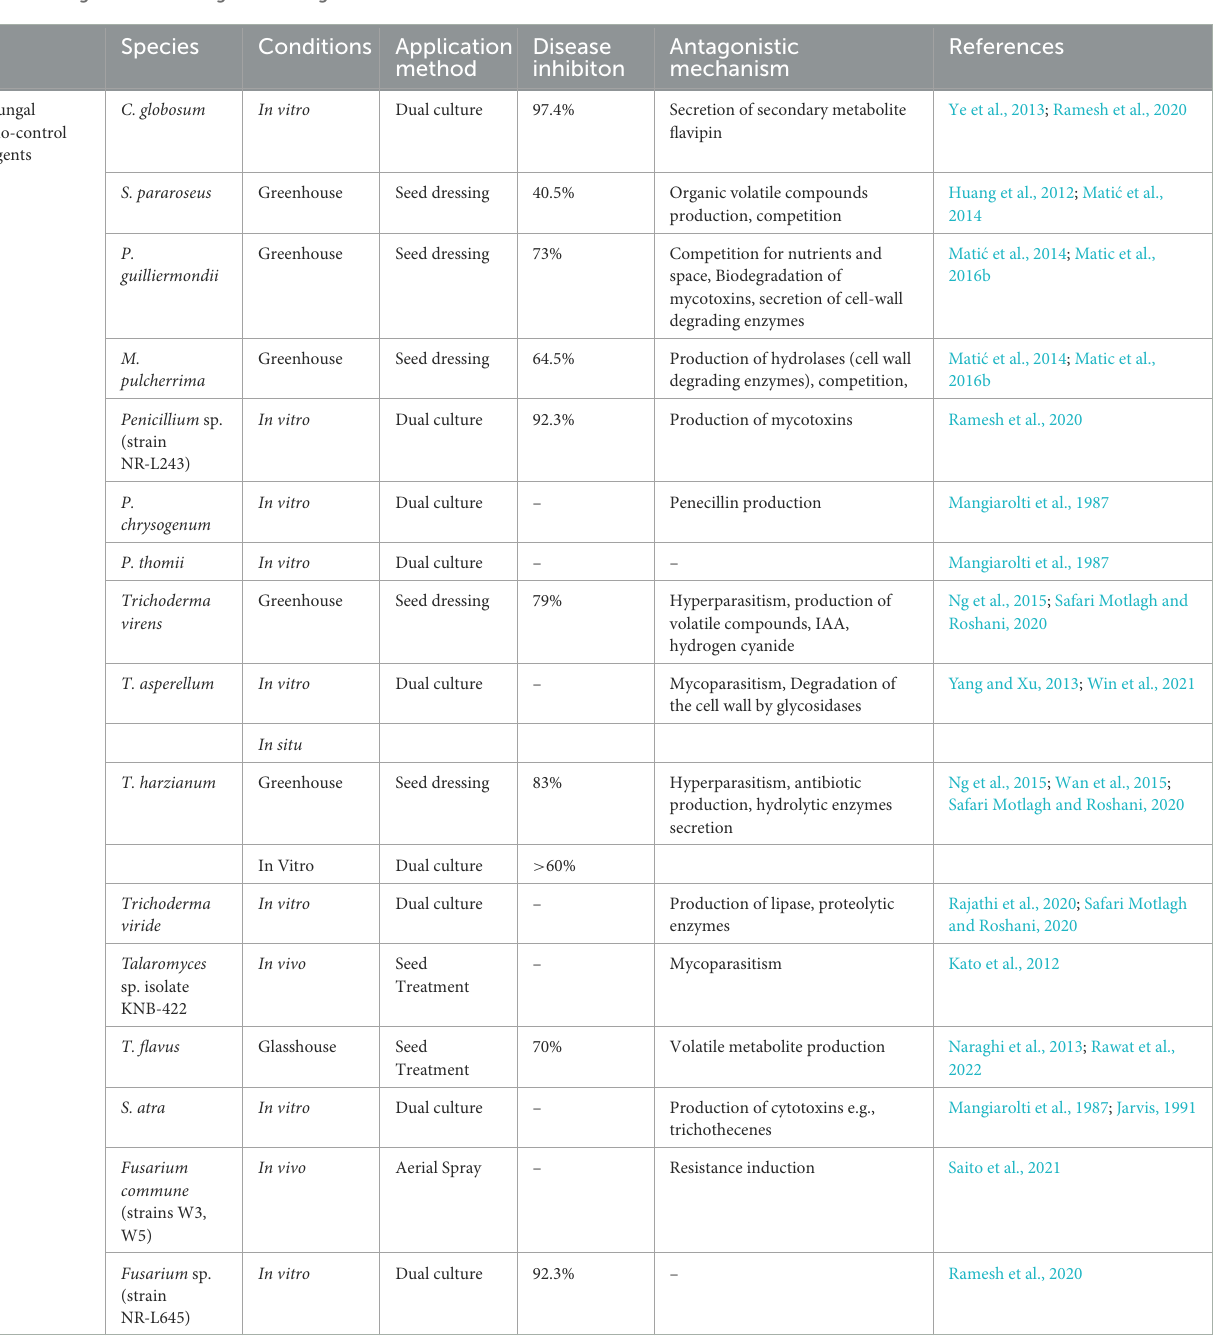
TABLE 2 Fungal bio-control agents used against the bakanae disease of